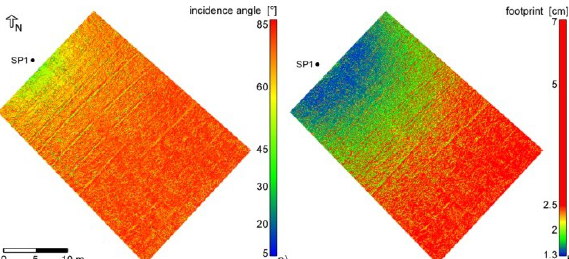
Figure 7: Illustration of consequences of unfavourable scan geometry, i.e. fast decrease of a) incidence angle and b) footprint with increasing distance from the scanning device (Example from SP1 of the field campaign